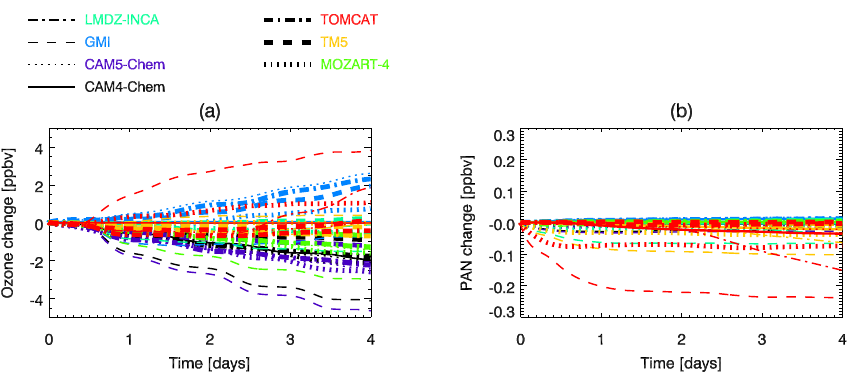
Figure 13. Time evolution of fire plume ozone (a) and PAN (b) from CiTTyCAT Lagrangian model simulations in which the initial plume concentrations from each of the POLMIP models have been used in combination with each of the forward trajectories from the different POLMIP model plume positions (shown in Fig. 12f). Different colours correspond to the POLMIP model initial chemical conditions and line styles correspond to POLMIP model forward